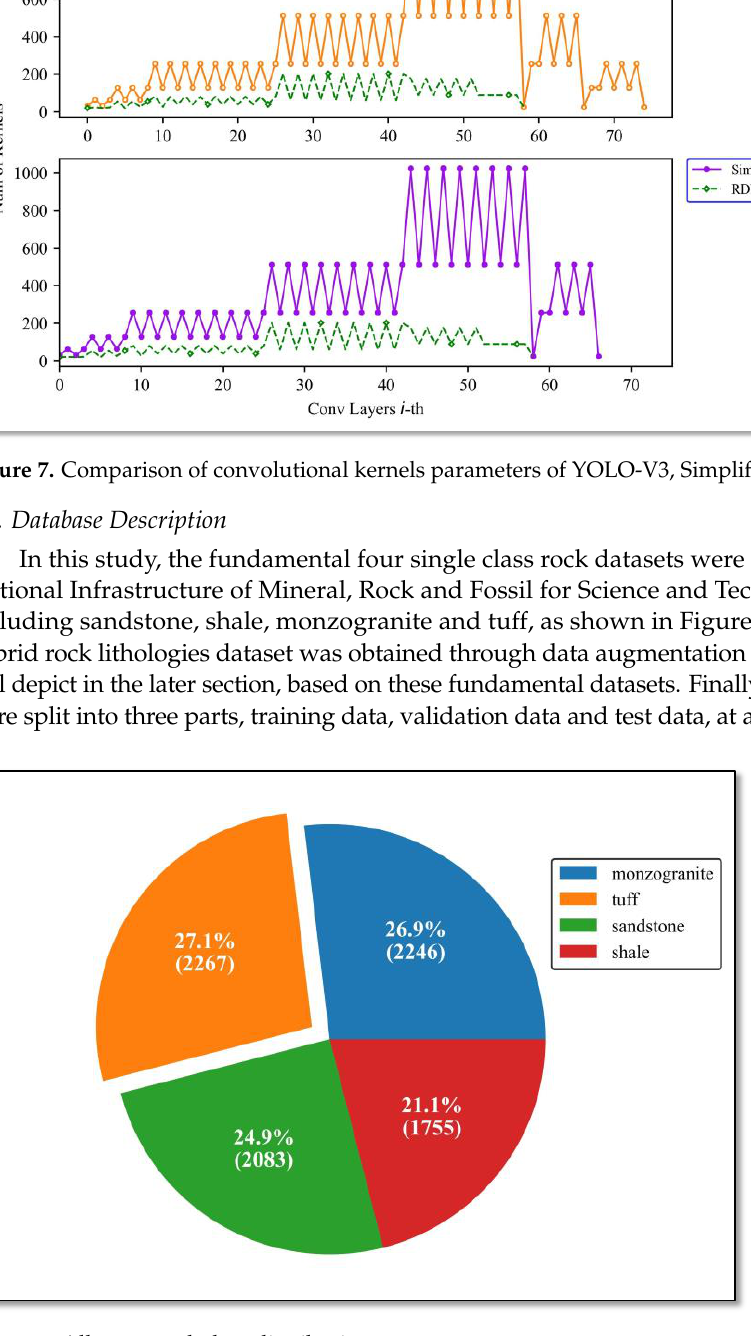
Table 3. Comparison between YOLO-V3, Simplified-Net and RDNet.